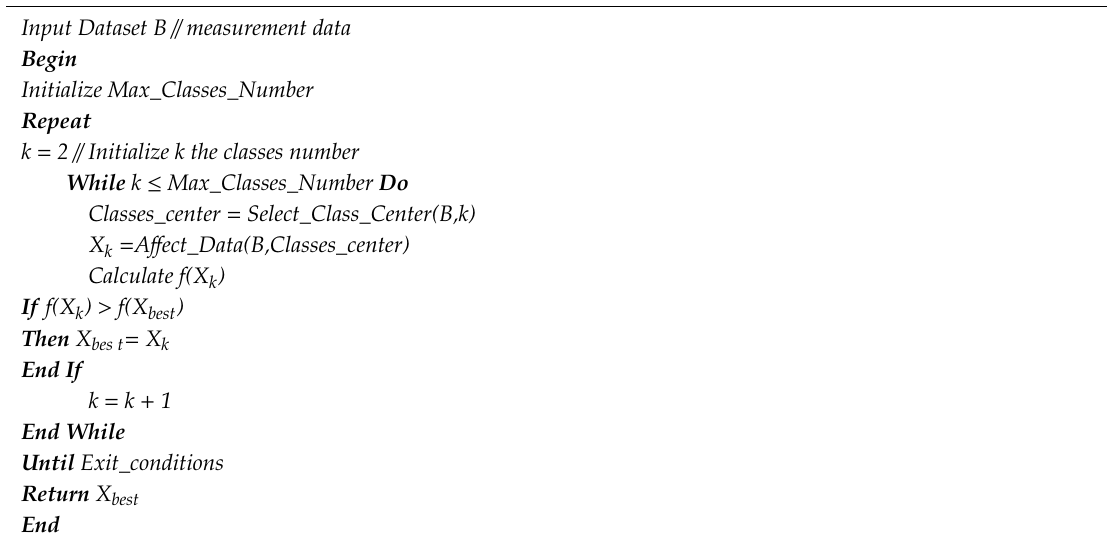
Algorithm 2. Random initial solution